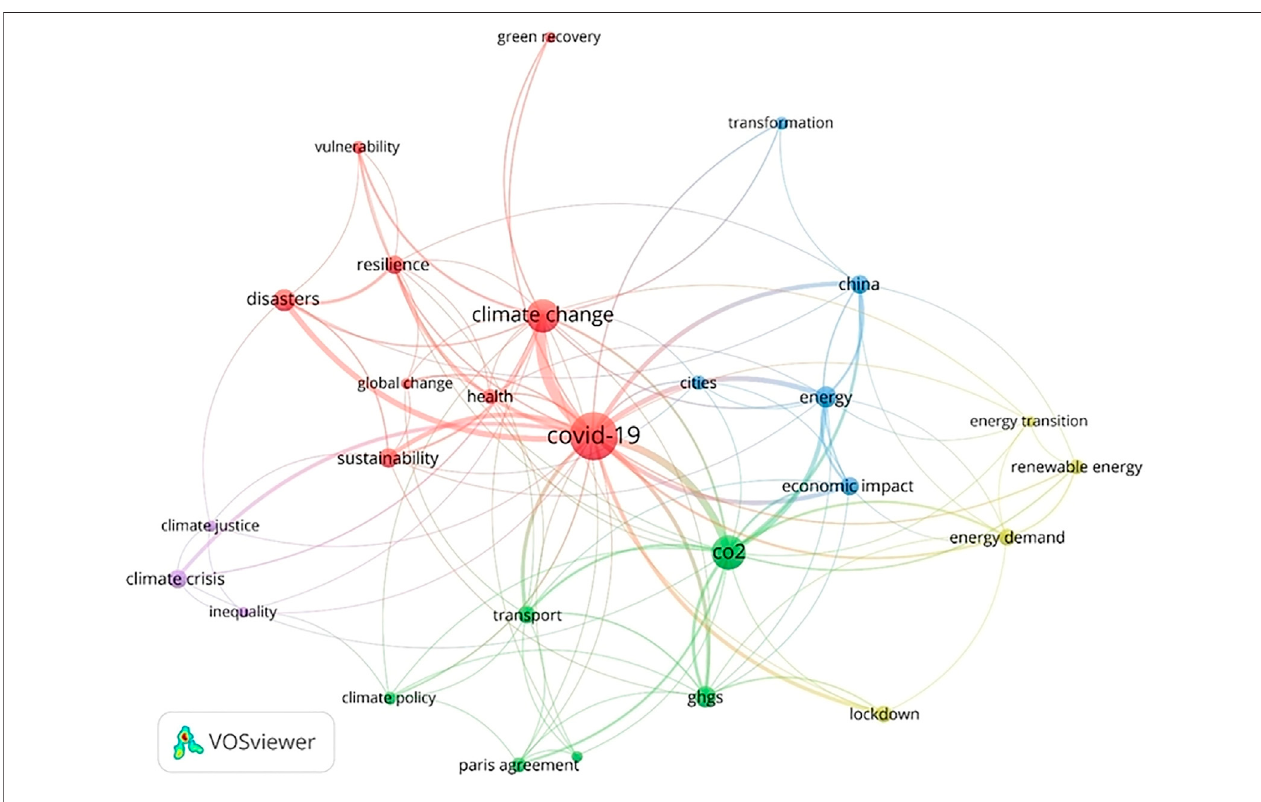
FIGURE 1 | Results of Bibliometric